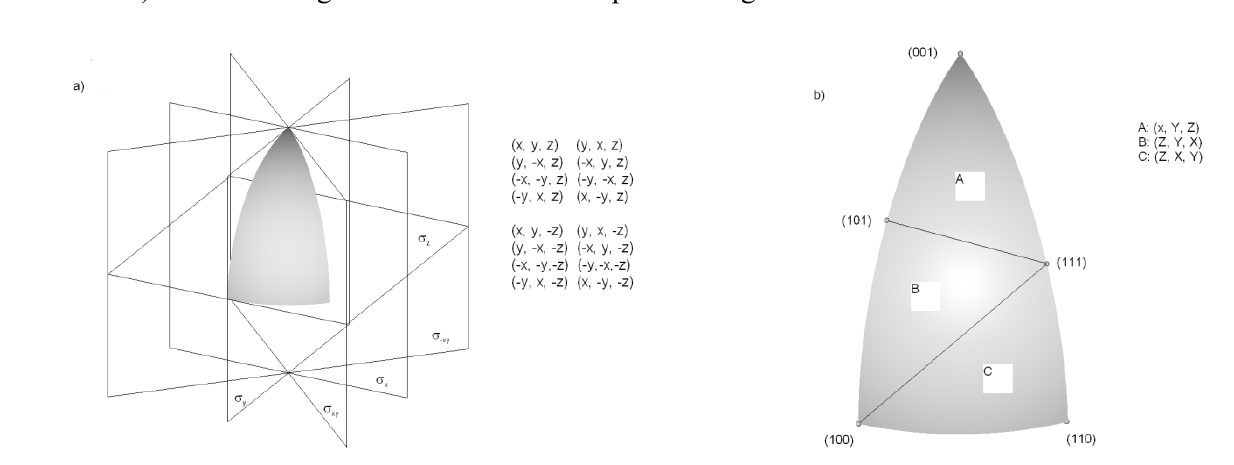
Figure 1. Etching rate interpolation region: (a) The angular section defined by the planes (0 ; 0 ; 0 ) x y x z N N N N     . (b) Irreducible triangles (1/48th part of the all full angular extent). Curved triangle A is used as the interpolation region.